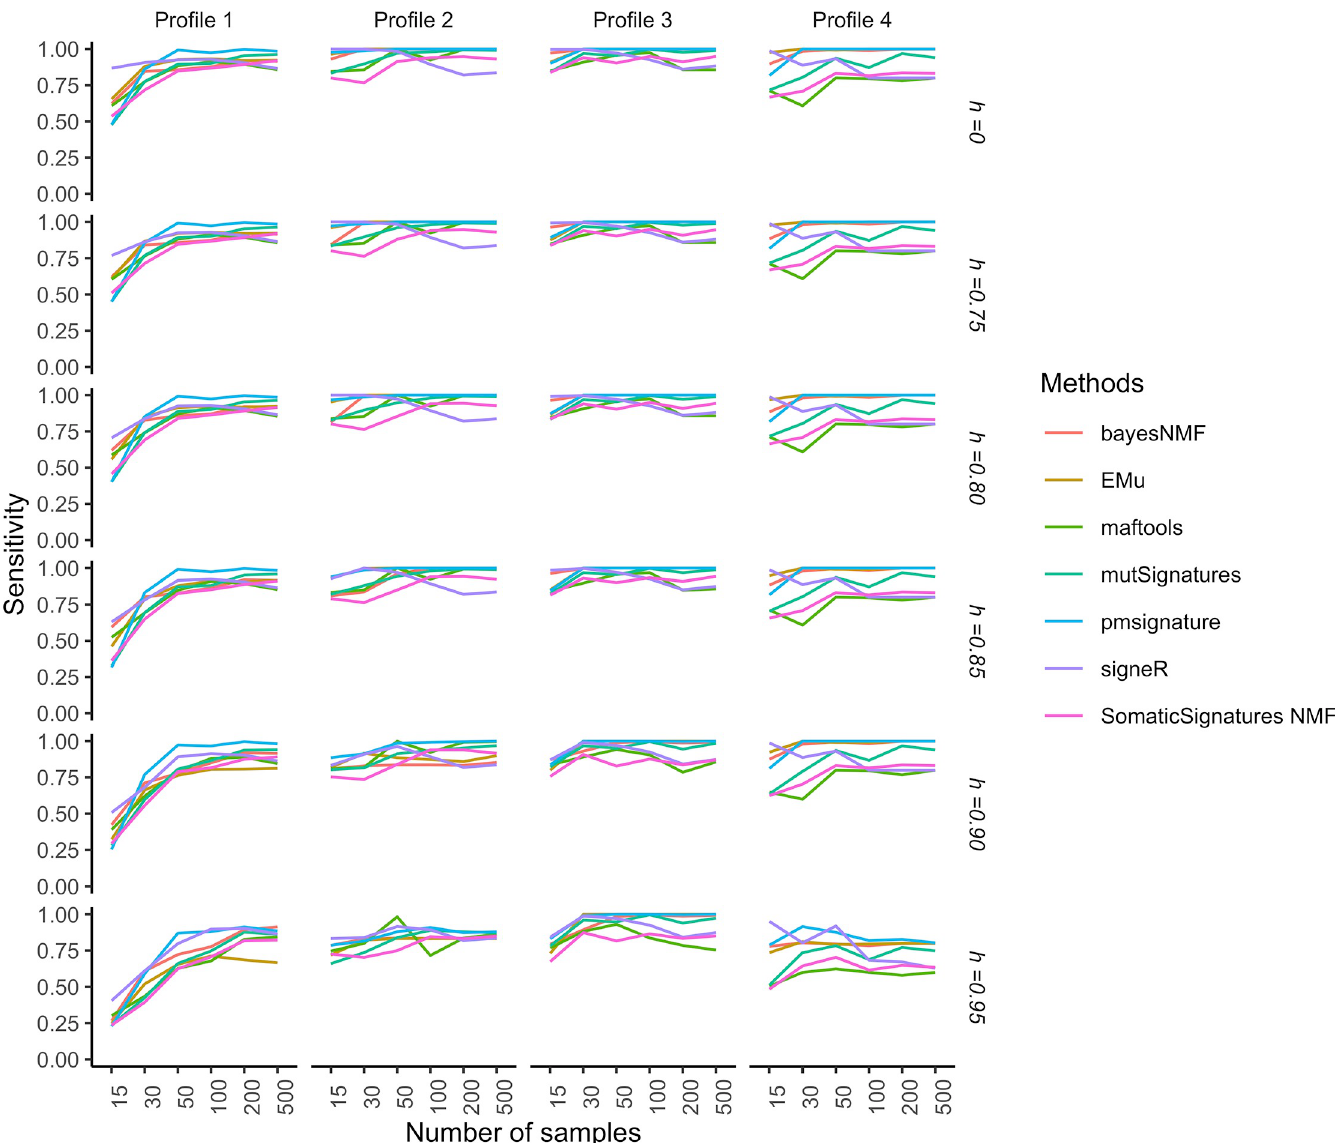
Fig 5. Simulation study: Sensitivity of extraction methods and mapping on COSMIC signatures as the number of analysed catalogues and the cosine cut-off h vary. Sensitivity is estimated from 50 replicates each made of G genomes. The average number of mutations in each catalogue is r = 10,000. The model used to simulate realistic replicates according to the four Profiles and the estimation methods are described in the section Data and experimental settings.